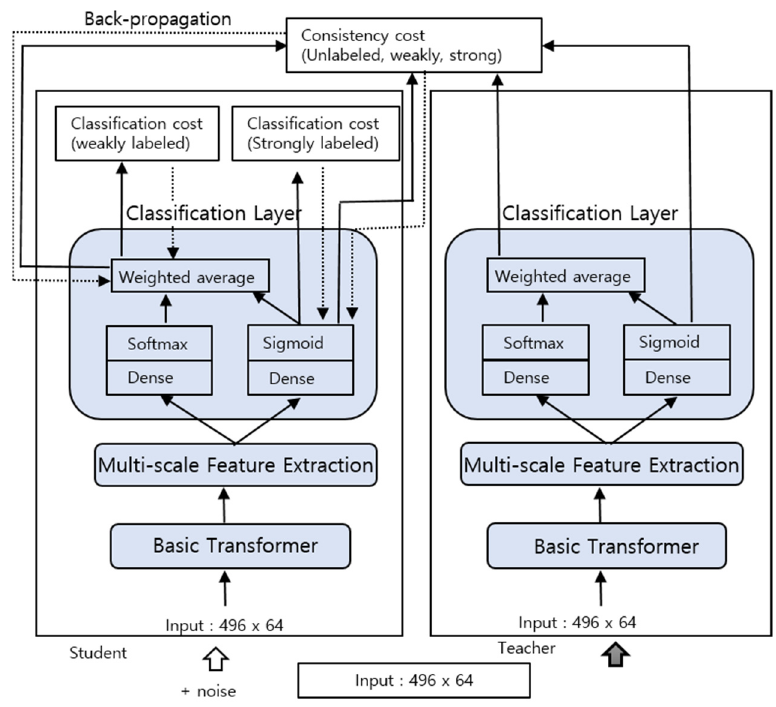
Figure 4. Structure of the mean-teacher Transformer model.